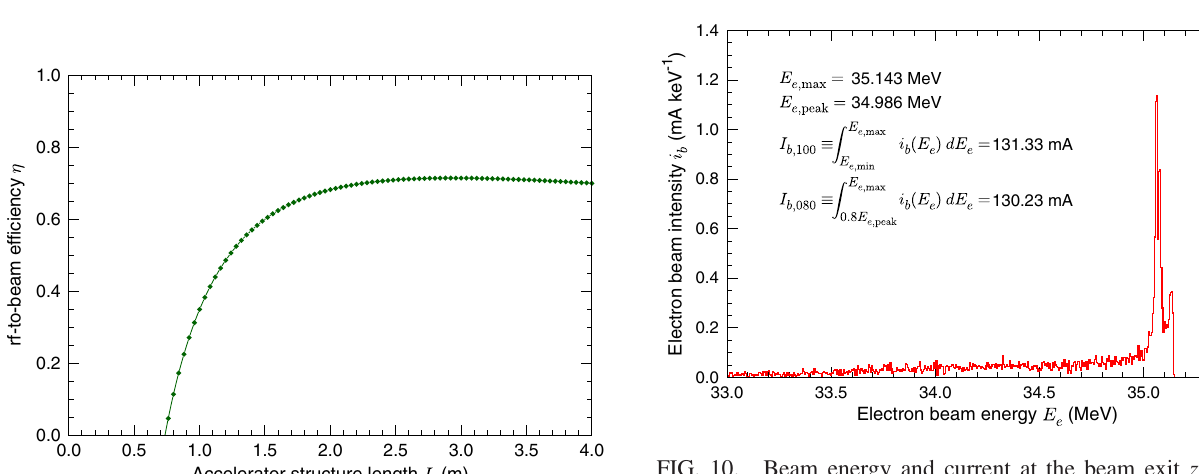
and E , e; min e; max , the e; peak